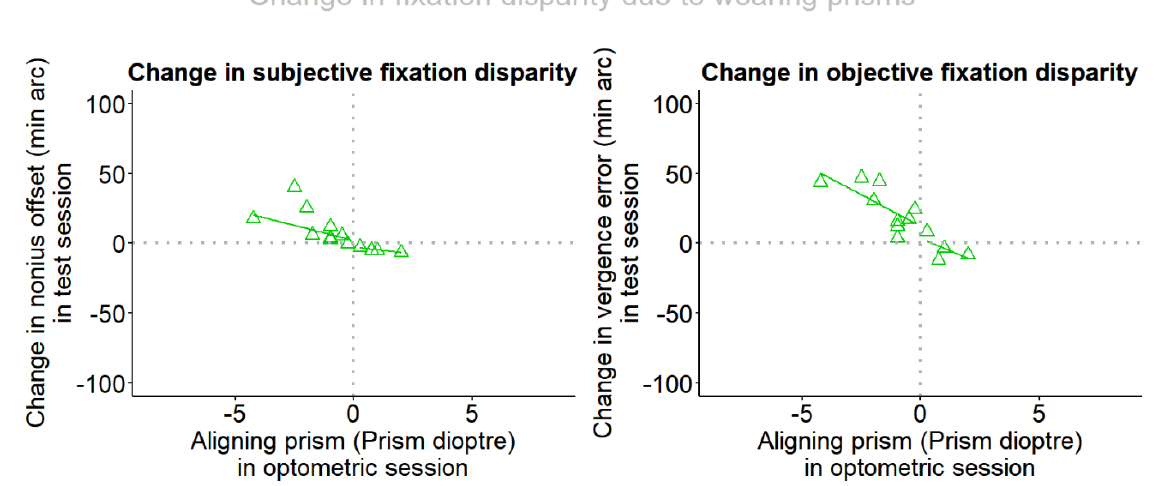
Figure 4: The change in subjective and objective fixation disparity as a function of the amount of the aligning prism. Separate robust regression lines are included for base-in and base-out